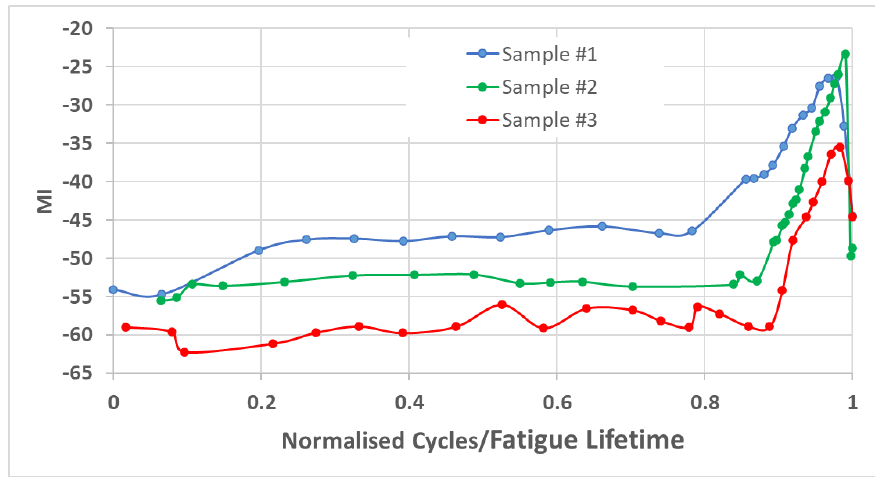
Figure 3. Measured dependence of the MI on the number of normalized load cycles/lifetime.